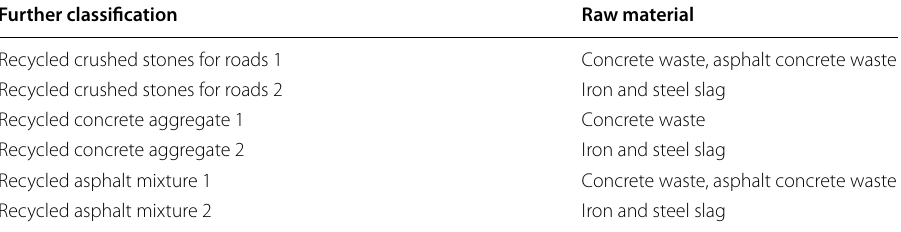
Table 1 Further classification of non‑metallic mineral waste sectors Further